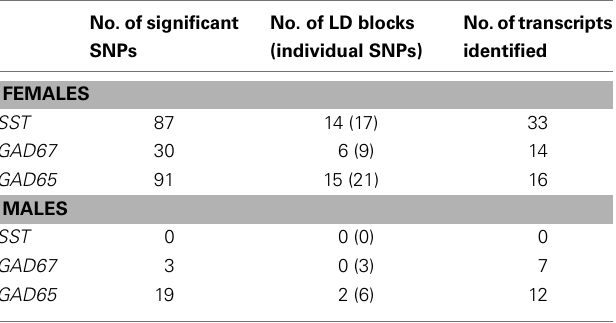
Table 6 | Summary of human frontal cortex (BA11/BA47) eQTL results for females and males.